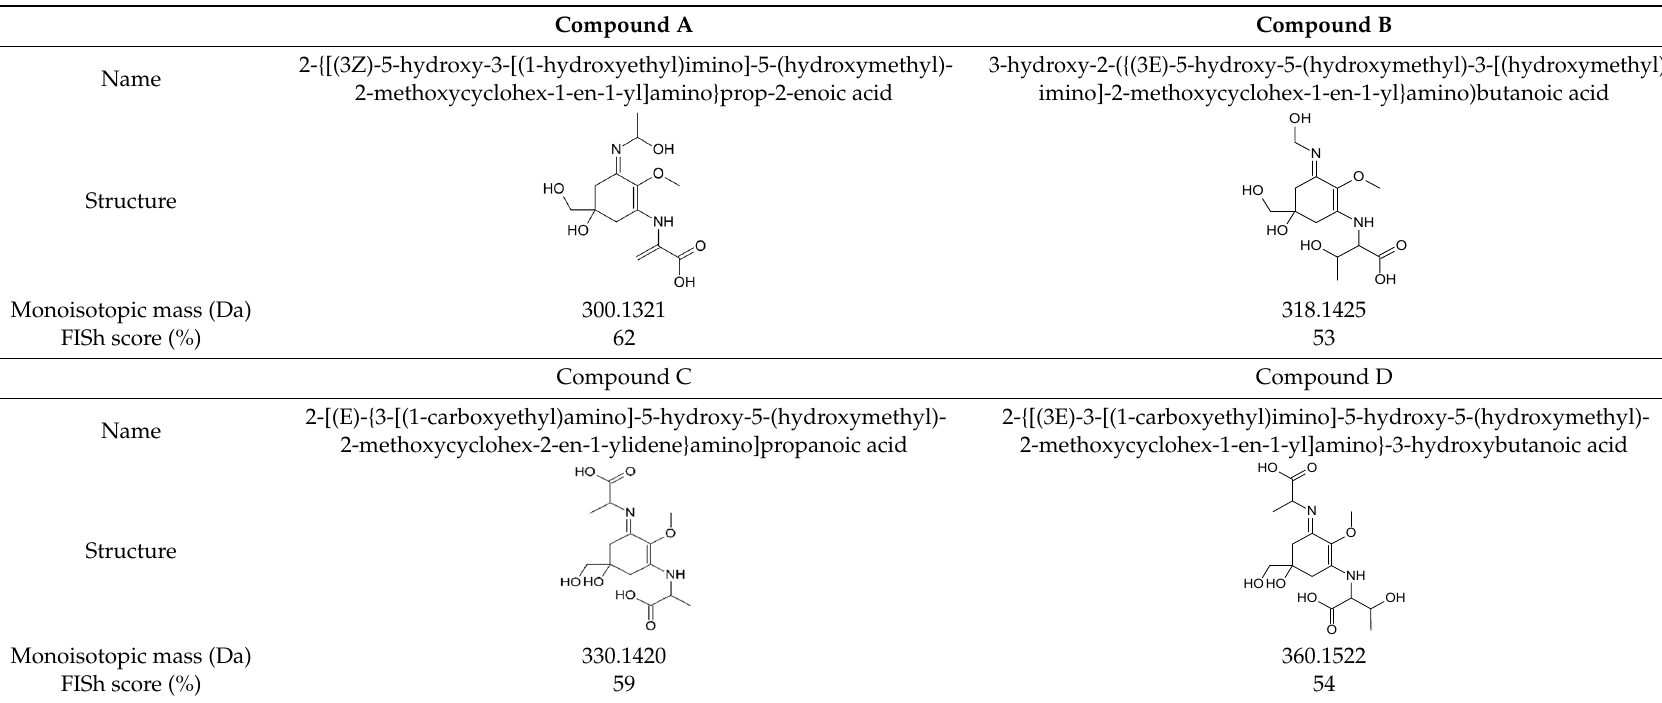
Table 6. Proposed structures of seven candidate-MAAs detected in the model algae Gymnogongrus devoniensis . The following structures were selected with the greatest FISh scores by comparing experimental and in silico fragmentation.